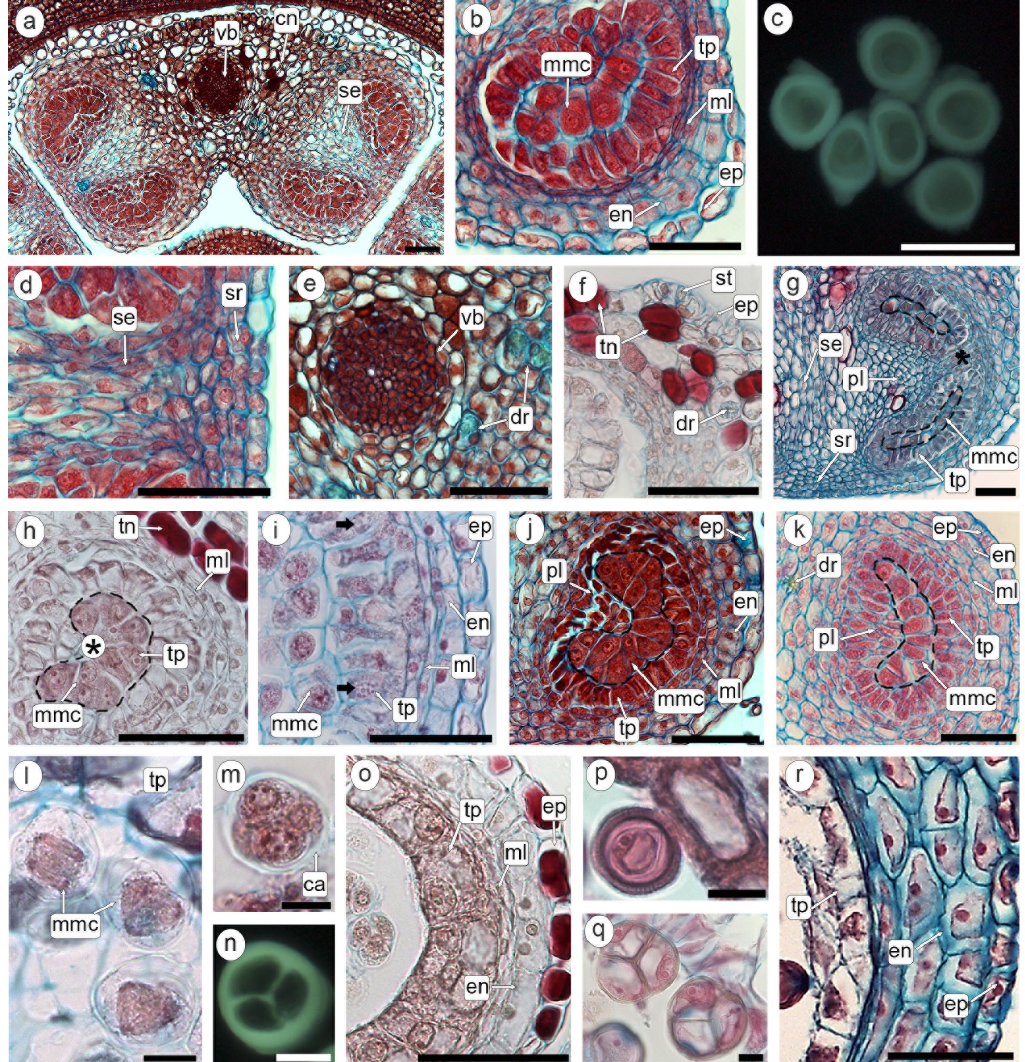
Figure 2. Cross section of anthers from the microspore mother cell stage (mmc) to microspore stages. a-e j, Randia calycina . f, h, l, o, p , Cordiera concolor. g, Tocoyena formosa . I, m, r, Genipa americana. k, n, q, Randia heteromera a, Anther (FSF). b , Portion of the anther where the mmc and several parietal strata are distinguished (FPF). c , mmc stained with aniline blue and observed under a fluorescence microscope (FSF). d , Septum and stomium region (FPF). e, Detail of the vascular bundle and cells with druses in the connective tissue. f , Portion of the connective tissue showing stomata, druses, cells with tannin in the epidermis and parenchyma (FPF). g , Detail of the placentoid (parenchyma + tapetum), the pollen sac is divided into two regions (*) due to the invasion of the placentoid. h , Detail of the anther showing: epidermis with tannin; tapetal cells with a large vacuole and the central mmc (*) in meiosis (FSF). i , Detail of an anther wall (FPF), the nuclei of the tapetal cells have several nucleoli (arrows). j , Tapetal placentoid in FSF. k , Tapetal placentoid in FPF. l,o-p ,, Cordiera concolor. n, q , Randia heteromera m, r , Genipa americana. l , Detail of the mmc in meiosis surrounded by uninucleated tapetum. m , Decused tetrad. n , Tetrahedral tetrad stained with aniline blue and observed with fluorescence microscope. o , Cross section of anther showing wall layers during stage 3. p , Free microspore; the nucleus is displaced by a large vacuole. q , Microspores joined together to form permanent tetrads. r, Anther wall with the cytoplasm of the tapetum cells contracted. Abbreviations: ca= calose; cn= connective tissue; dr= druse; en= endothecium; ep= epidermis, ml= middle layers; mmc= microspore mother cell; pl= placentoide; se= septum; sr= stomiun region; st= stomata; tn= tannin; tp= tapetum; vb= vascular bundle. Scales: a-k, o, r= 50 µm,l-n, p-q= 10